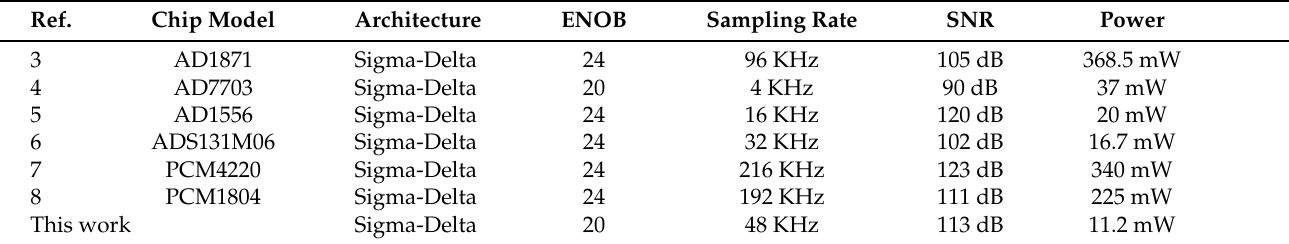
Figure 9. Spectrum of the digital decimation filter output signal. Table 1. Performance comparison with similar